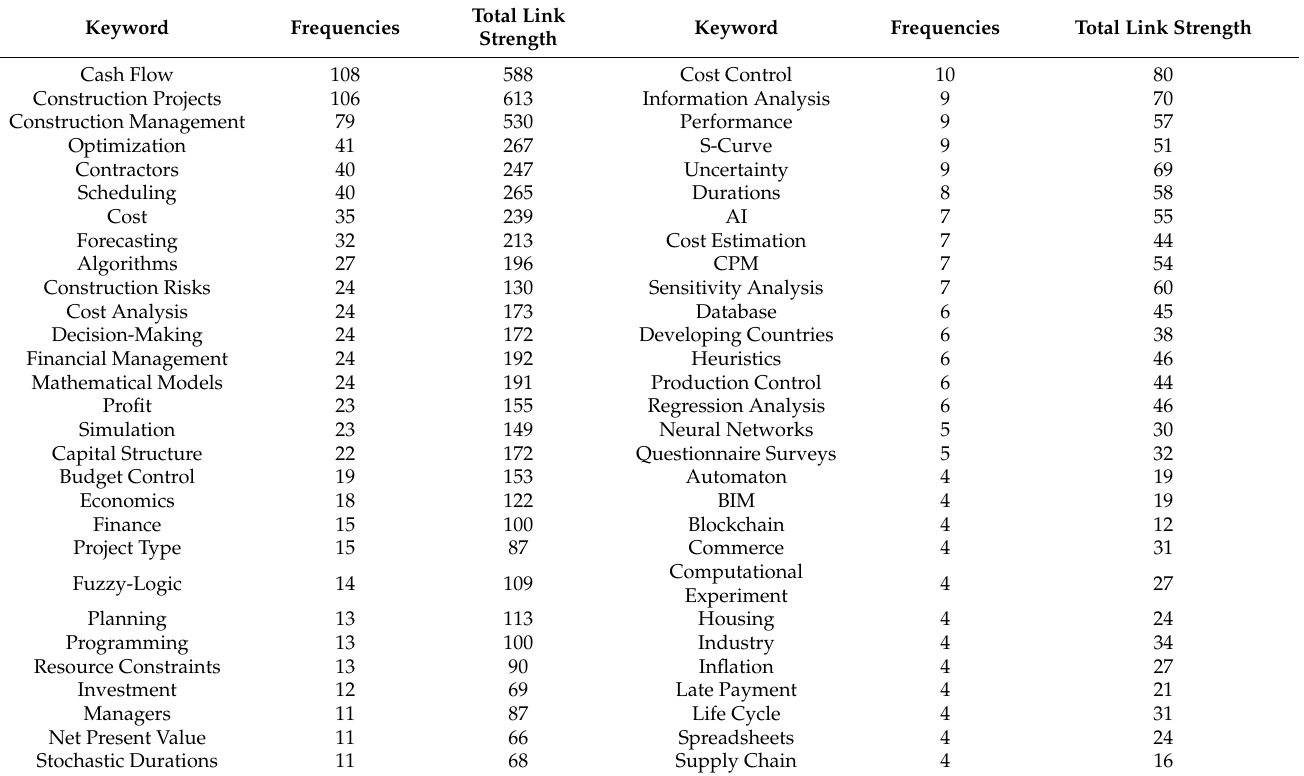
Table 2. Top keywords used in the retrieved articles .